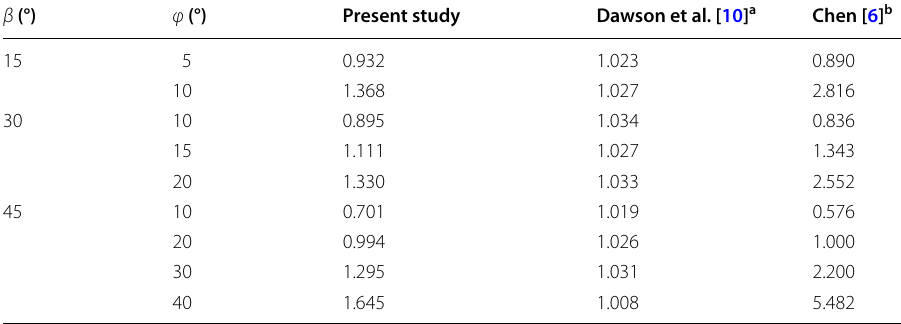
Table 6 A comparison of F obtained by Dawson et al. [10] and Chen [6] with the present solutions s for homogeneous slopes of 10 m height